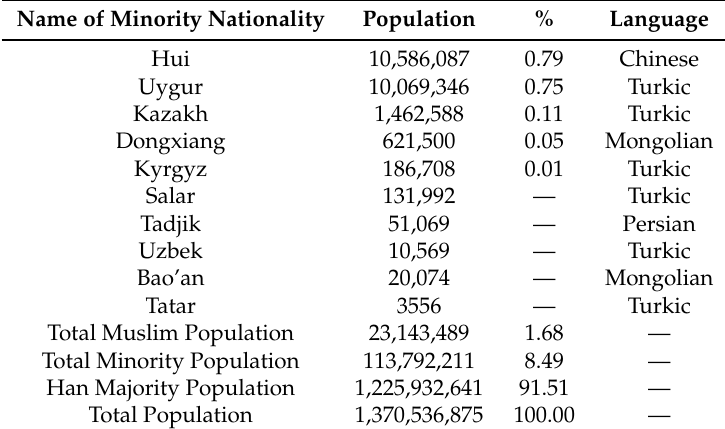
Table 1. Muslim Population of China, 2010